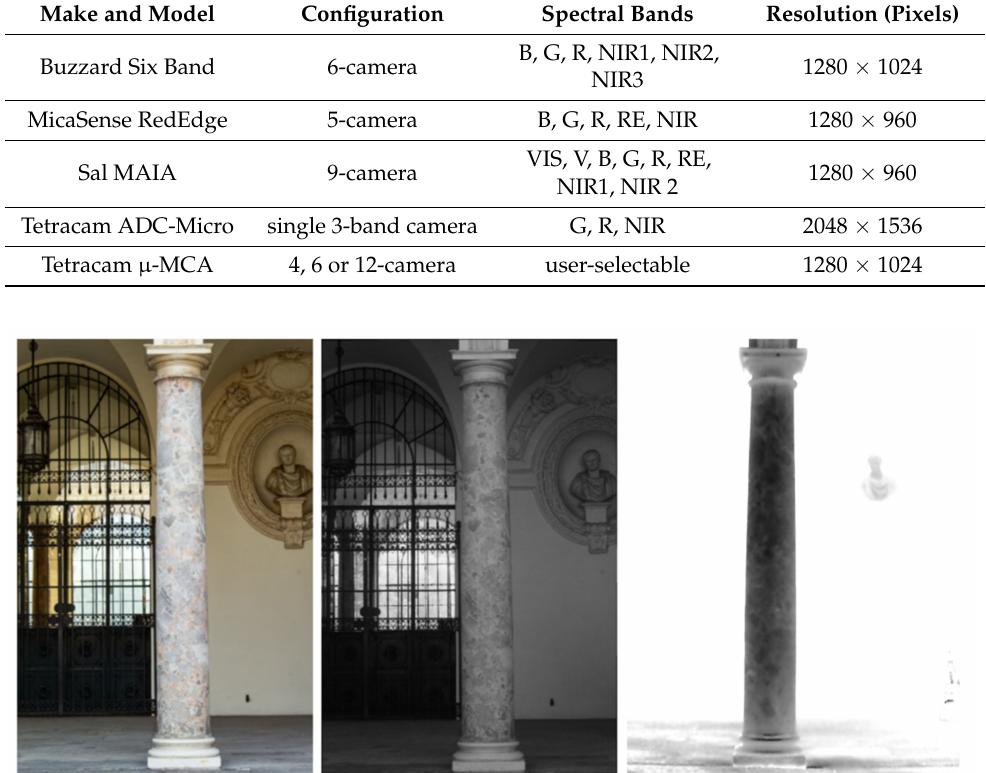
Figure 6. Spectral images captured at Turin’s Castello del Valentino (Italy) main façade, right column: ( left ) color; ( center ) very near-infrared reflectance; ( right )